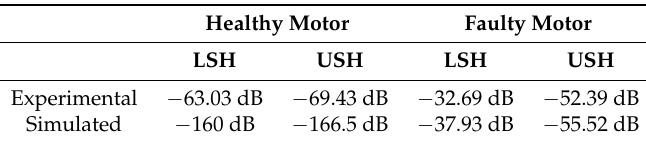
Table 1. Magnitude of the main fault harmonics generated by a broken bar fault in the tested and simulated motors.